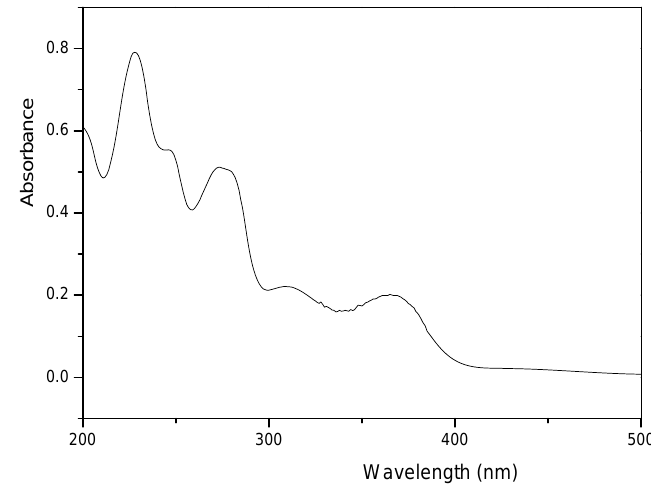
Fig.8S UV spectrum of